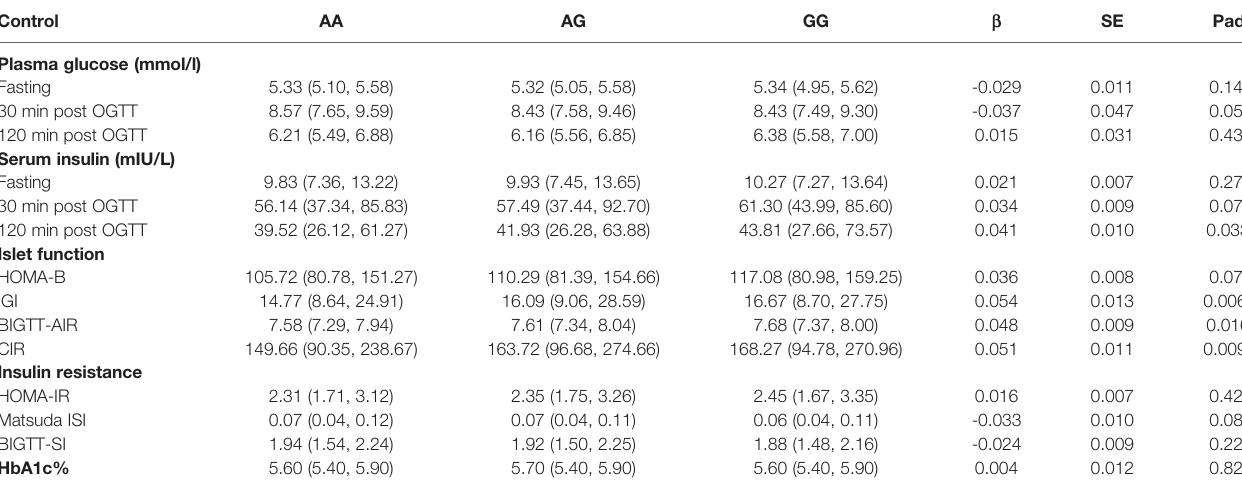
TABLE 3 | The association of the JAZF1 rs864745 A>G variant with glycemic quantitative traits in healthy individuals based on OGTT. Control